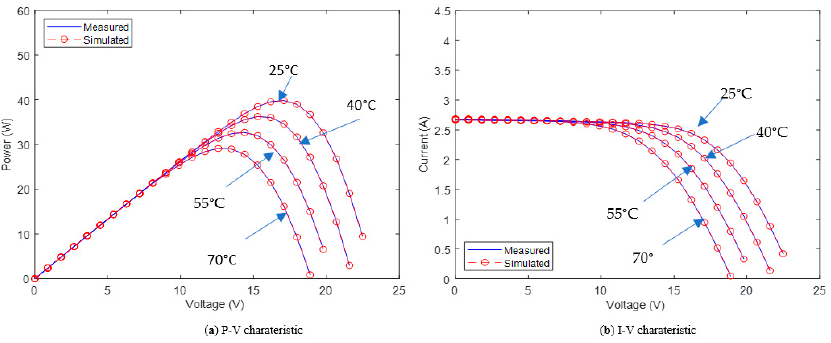
Figure 27. Depiction of the measured and simulated data on the ST40 module under G = 1000 W/m 2 with four different temperature levels.